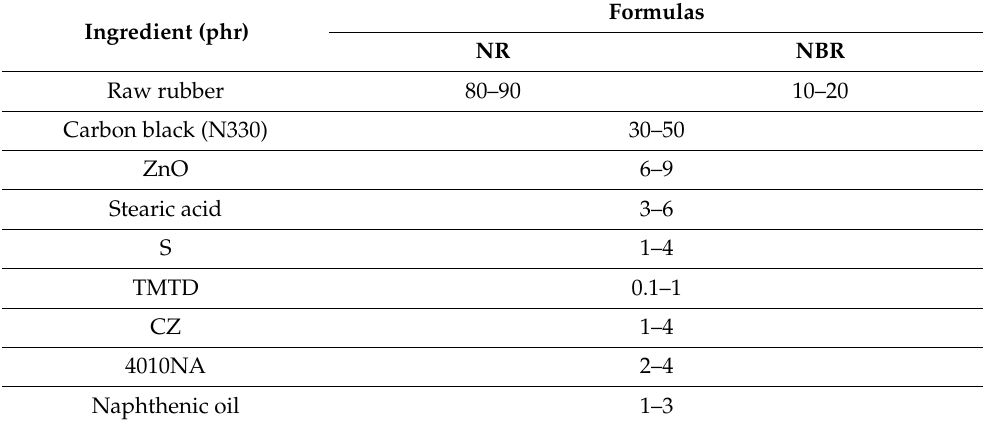
Table 1. Basic formulation of the rubber material (unit: parts per hundred rubbers [phr]).